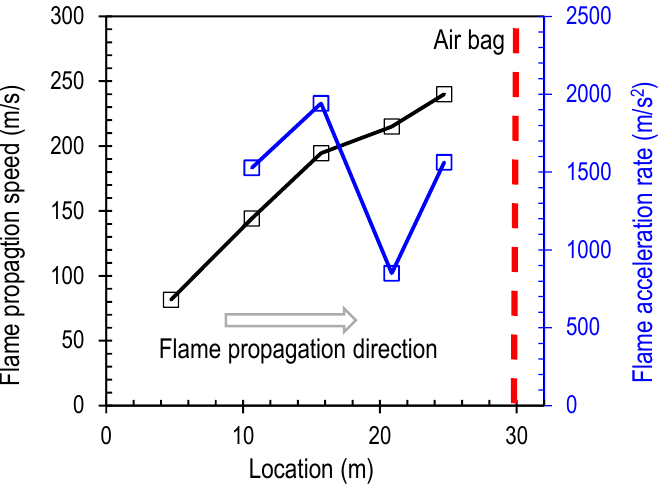
Figure 9. Flame propagation speed and acceleration rate at different locations for the scenario where Obstruction 1 and Obstruction 2 are not inflated, and Obstruction 3 is half inflated (with a 50% blockage).